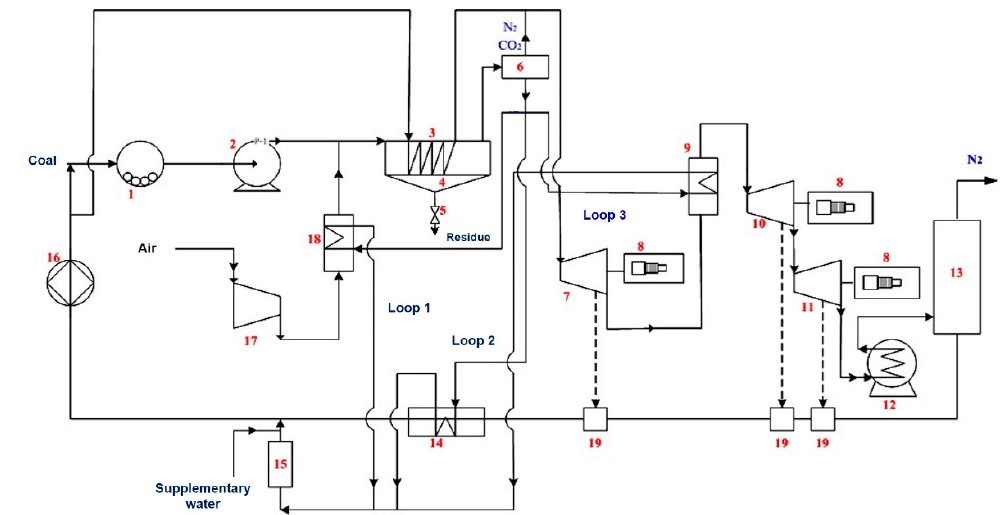
Figure 11. Schematic diagram of SCHC coupled power generation system (adapted from [21]) 1—